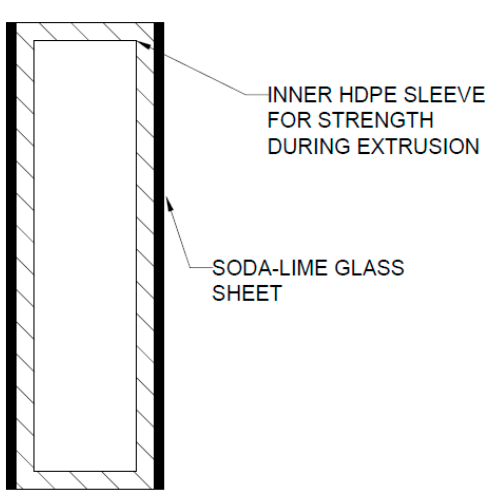
Figure 1. The glass-reinforced composite column (GRCC) is first assembled using an inner sleeve to hold the glass in place during the over jacketing extrusion process.